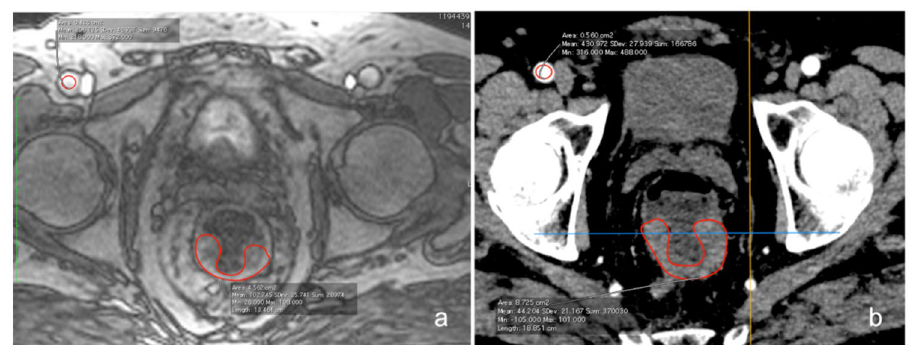
Figure 3. Example of corresponding rectal cancer tumour areas and positioning of ROIs for the assessment of arterial input function (AIF) for perfusion: ( a ) Example of a manually drawn ROI for assessment of AIF over the right superficial femoral artery and a manually drawn ROI for perfusion analysis over a representative slice of tumour area on MR perfusion images. ( b ) Example of the manually drawn ROI for assessment of the arterial input function (AIF) over the right superficial femoral artery in analogy to ( a ) and a manually drawn ROI for perfusion analysis in the identical representative slice of tumour area on dVPCT images corresponding to ( a